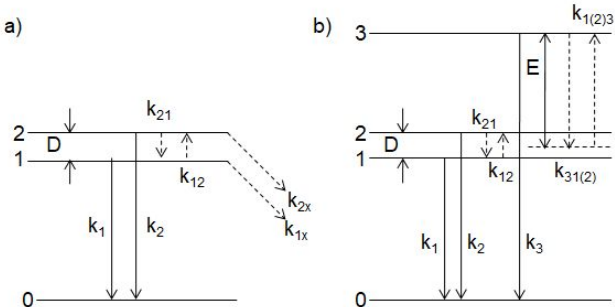
Figure 10. Energy level diagrams used for the description of the excited states dynamics of the Bi 3 + -related luminescence centers responsible for the VIS emissions. In ( a ) two-excited-level diagram, in ( b ) three-excited-level diagram. For details, see the text.